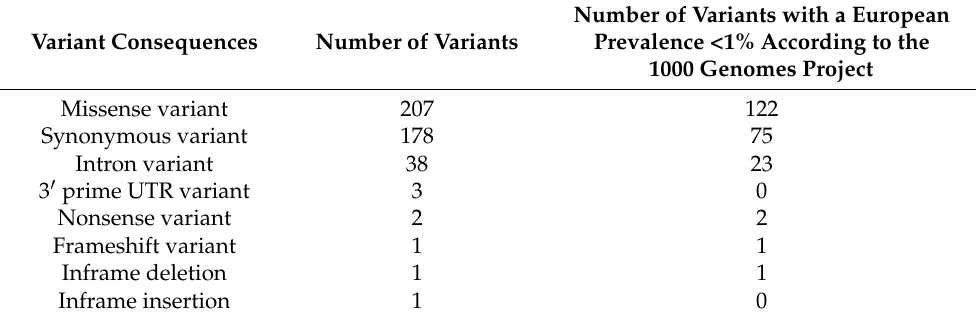
Table 2. Variants classified by consequence.